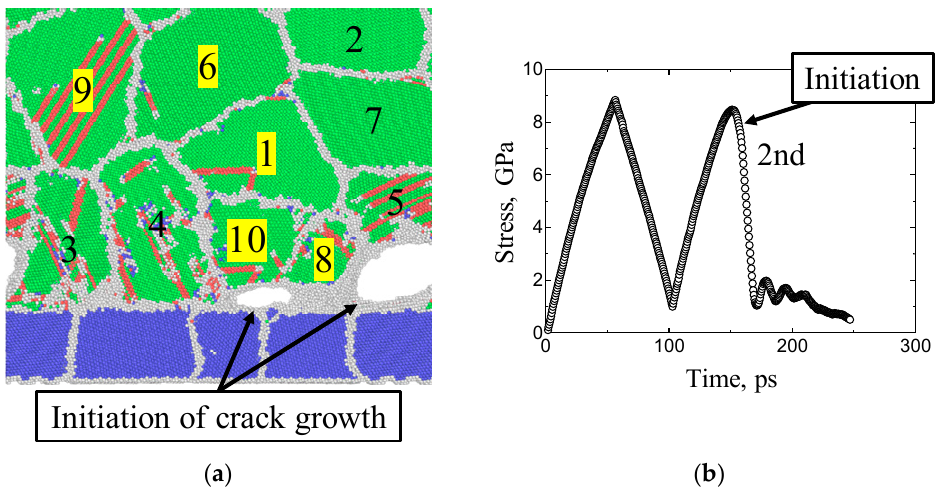
Figure 16. Snapshot at the time of fatigue crack initiation ( a ) and transition of stress during cyclic loading ( b ) when a maximum tensile stress of 8.80 GPa was applied to Model 2.